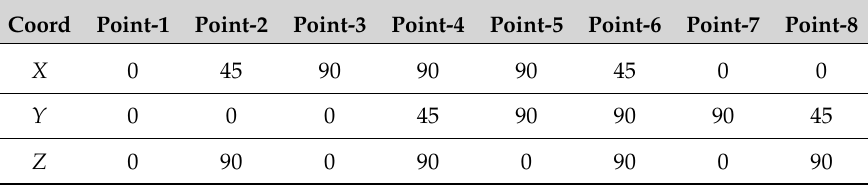
Table 4. 3D coordinate of turn points in Figure 10c.